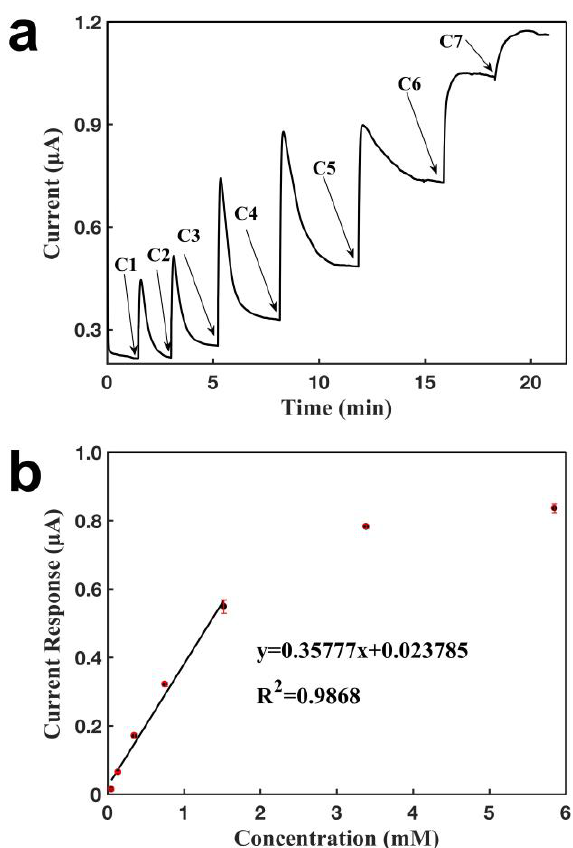
Figure 6. Characterization of glove sensor based on a CNT electrode and an Ag/AgCl electrode for the detection of lactate. Operating potential: 0.6 V of the working electrode vs reference electrode (Ag/AgCl 50:50). ( a ) Current-versus-time response curve upon the additions of lactate. C1: 0.048 mM, C2: 0.089 mM, C3: 0.30 mM, C4: 0.40 mM, C5: 0.77 mM, C6: 1.86 mM, C7: 2.47 mM. ( b ) Calibration curve for the detection of lactate. Each error bar was from three measurements.